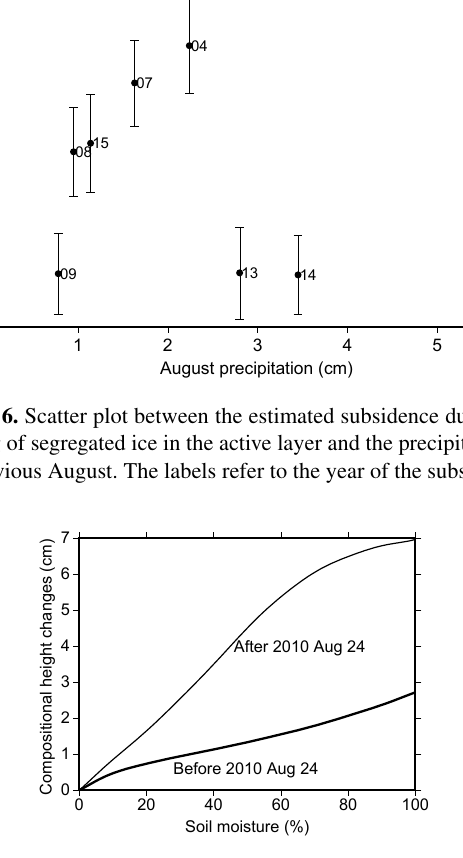
Figure 7. Changes of compositional height (i.e., apparent reflector height) with soil moisture based on the simulated SNR data using two antenna models: TRM29659.00 was used before 2010 Aug 24; TRM59800.80 was used after 2010 Aug 24.